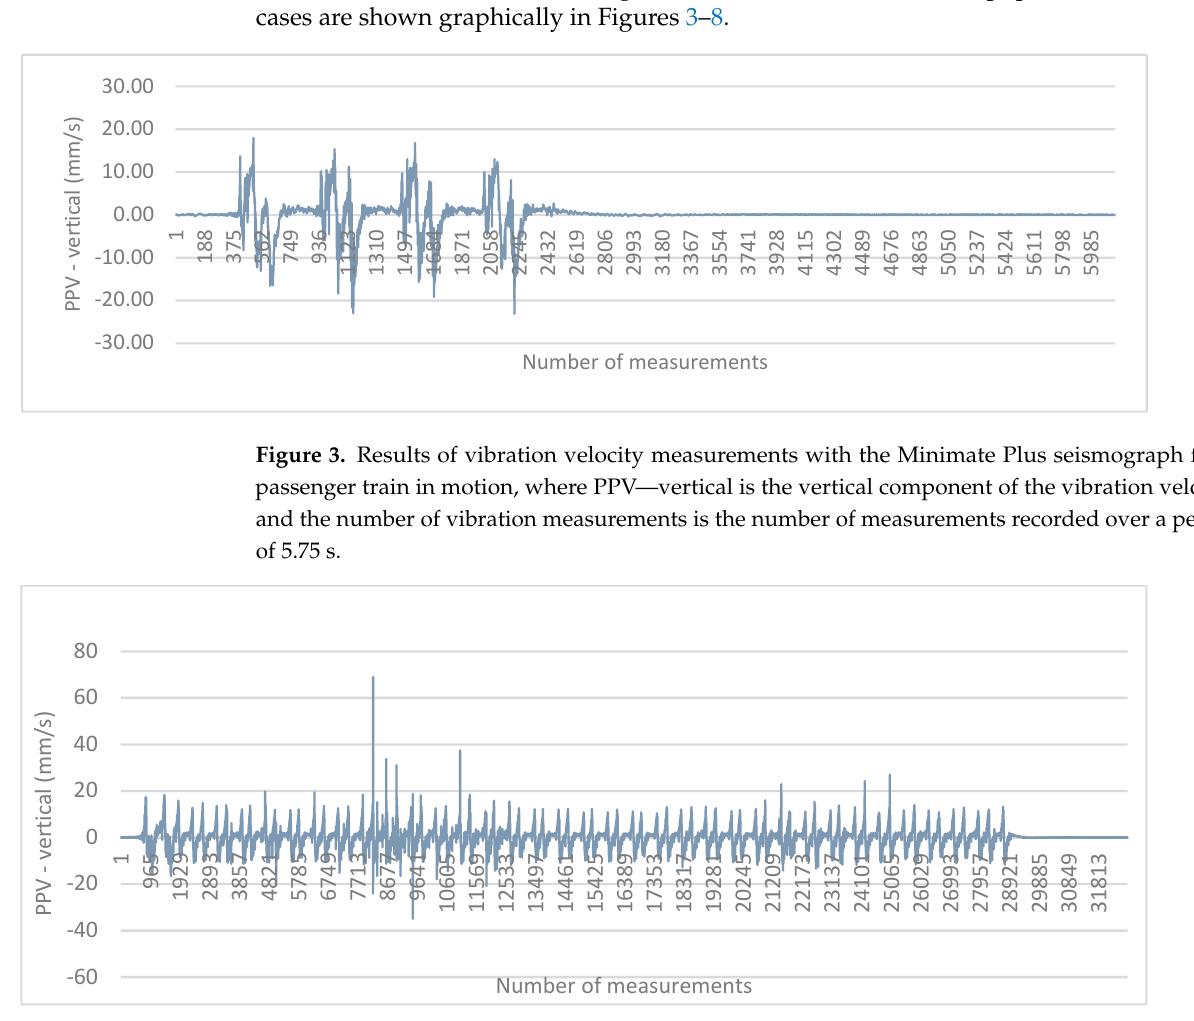
Figure 4. Results of vibration velocity measurements with the Minimate Plus seismograph for a freight train in motion, where PPV—vertical is the vertical component of the vibration velocity and the number of vibration measurements is the number of measurements recorded over a period of 31.75 s.